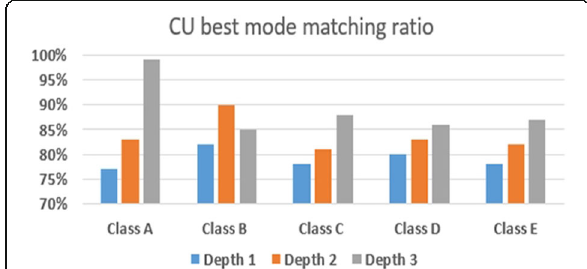
Fig. 7 The best CU mode matching ratio of different sequences and different